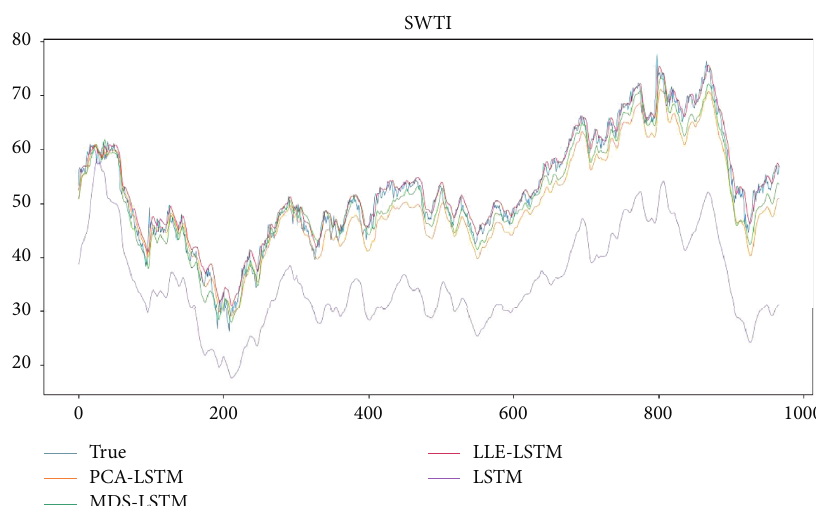
Figure 13: Prediction results of crude oil spot prices by the LSTM benchmark model.